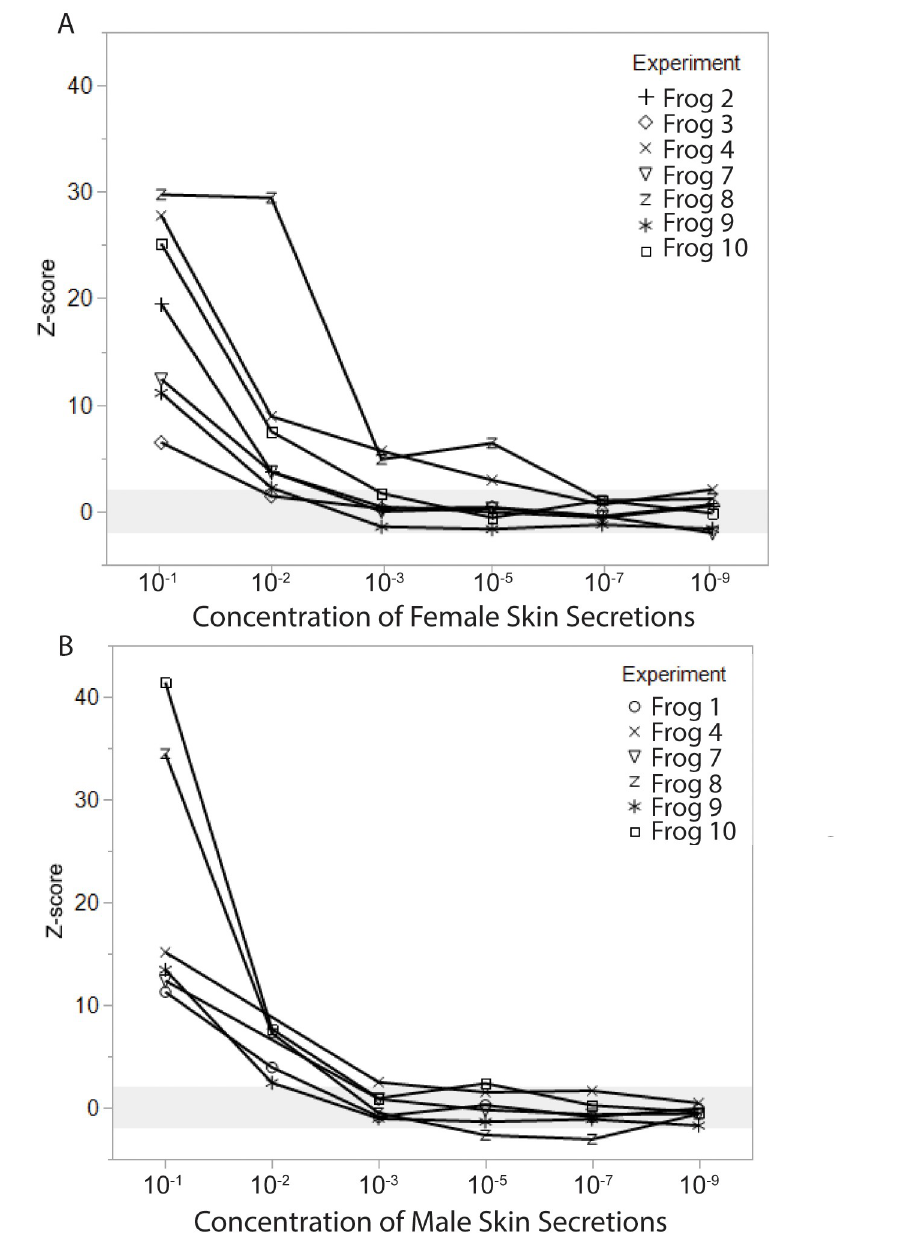
Fig 6. EOG responses to skin secretions from female and male conspecifics, represented as z-score relative to skin control stimuli. (A) EOG amplitudes in response to female skin secretions were well above the detection threshold at concentrations of 10 − 1 and 10 − 2 , and may still have been detectable for some animals at 10 − 3 and 10 − 5 . (B) EOG responses to male skin secretions were similar to those seen in A for the most concentrated stimuli, with a detection threshold between 10 − 2 and 10 − 3 for most animals.